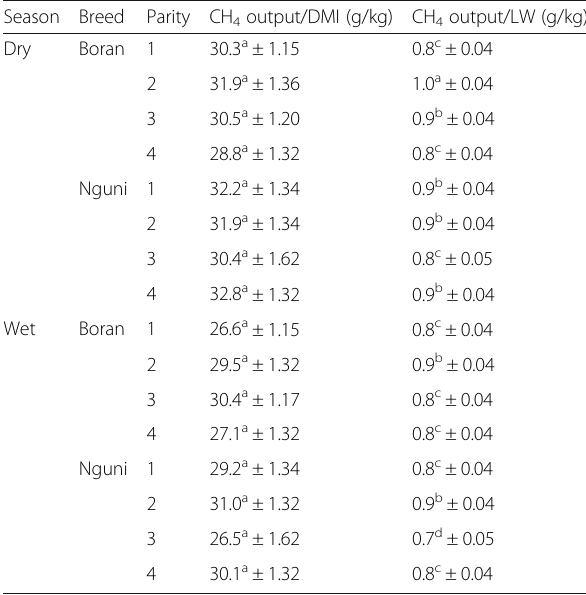
Table 2 Ratio of methane output per kilogramme DMI and methane output per kilogramme of live weight from the two herds